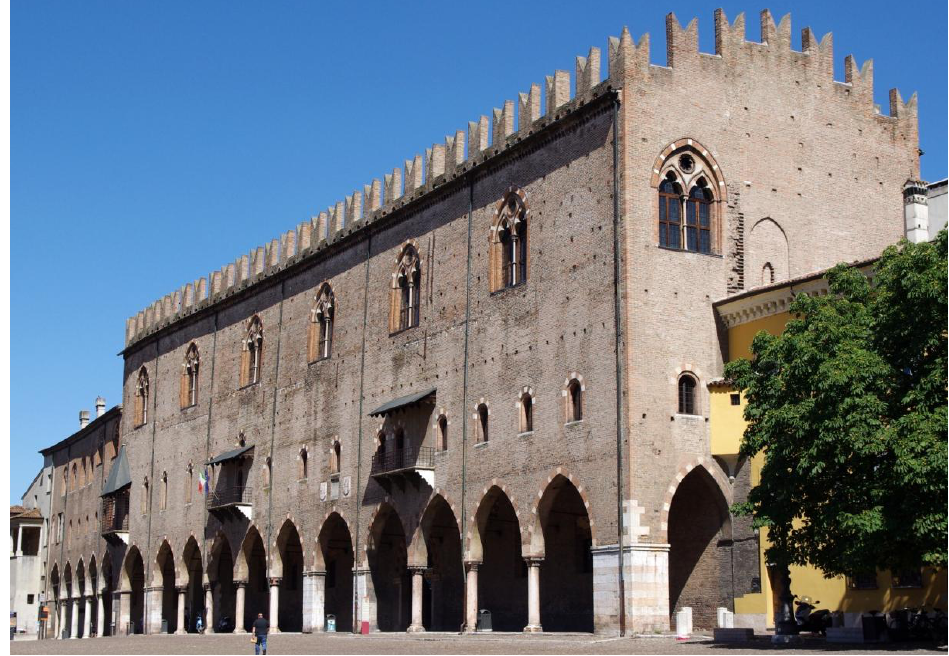
Figure 1. Palazzo del Capitano in Mantua. View from Piazza Sordello